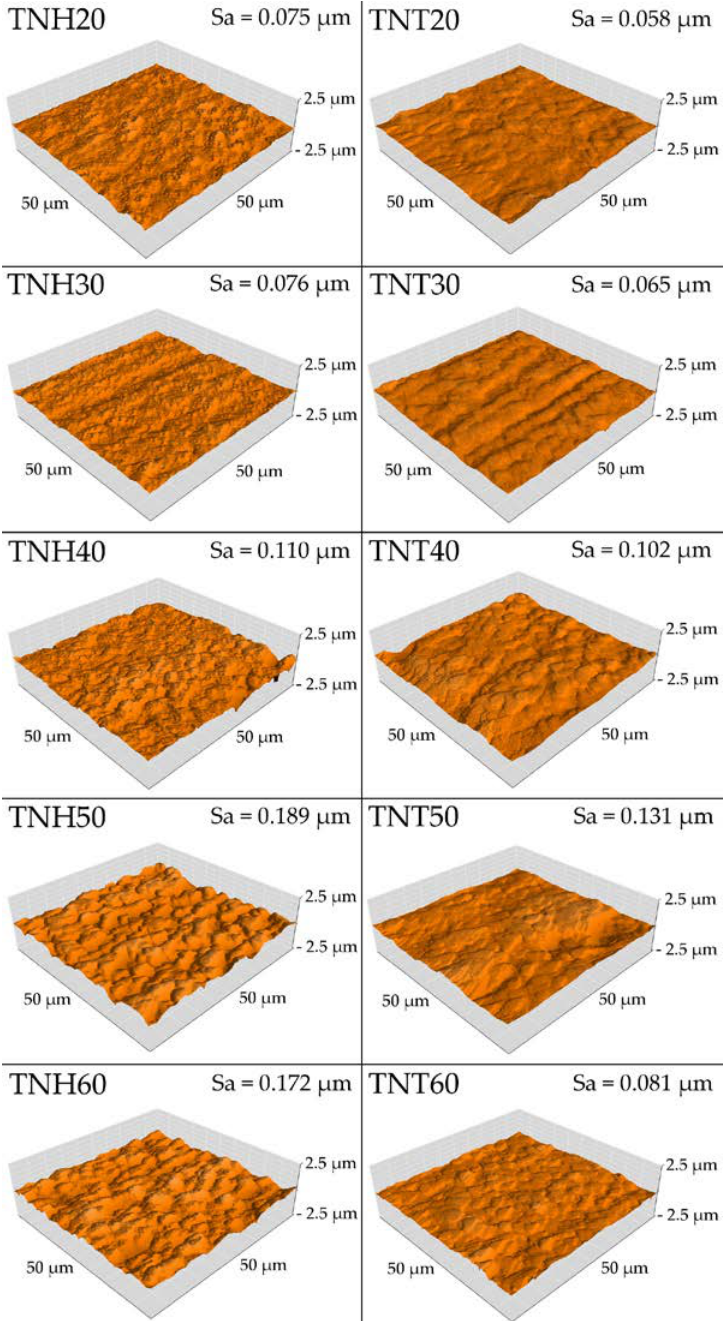
Figure 6. Atomic force microscopy (AFM) topography of Ti6Al4V/TNH20-60 and Ti6Al4V/TNT20-60